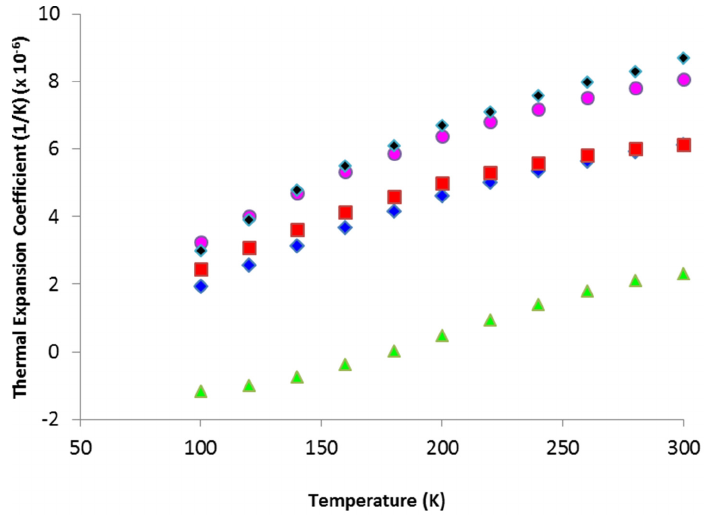
Figure 20. Thermal expansion coefficient as a function of absolute temperature for the isotropic laser materials YAG (blue) and LuAG (red) [29], and for the biaxial laser material YALO [29] along the a (green), b (pink), and c (black) axes. All data are for undoped crystals.